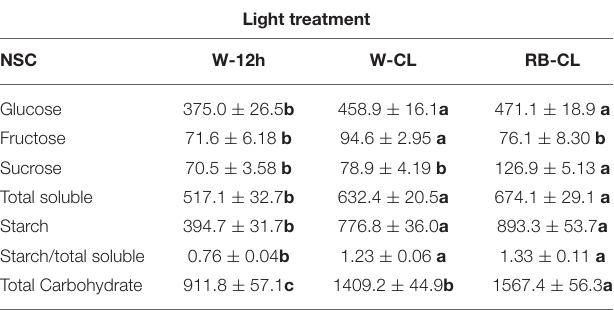
TABLE 2 | Non-structural carbohydrate (NSC, as mg · 100g FW − 1 ) content in the leaves of Eruca vesicaria (L.) Cav. grown under three different light treatment conditions.